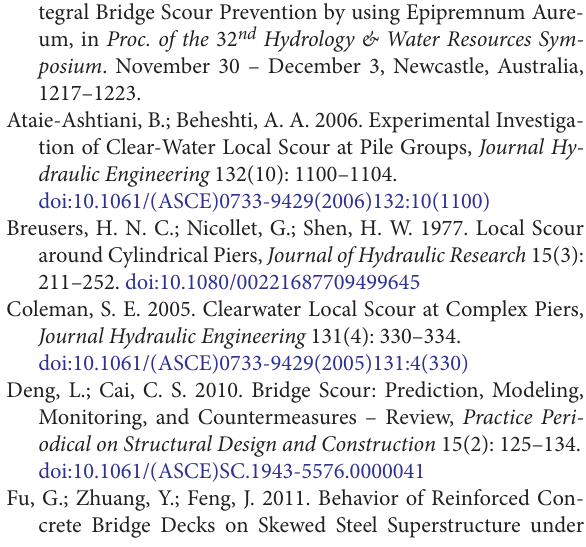
Fig. 23. Effect of vehicle location on pile